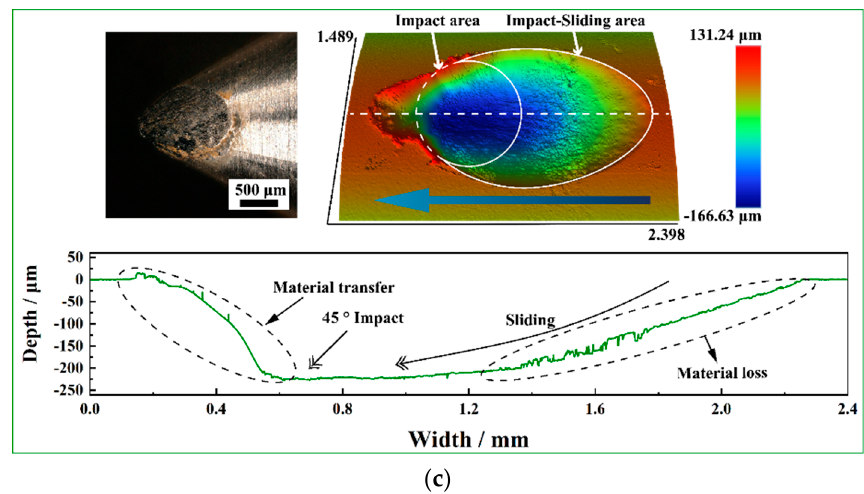
Figure 10. Wear of impact blocks and tube specimens at different impact angles. ( a ) θ = 90°; ( b ) θ = 60°; ( c ) θ = 45°.